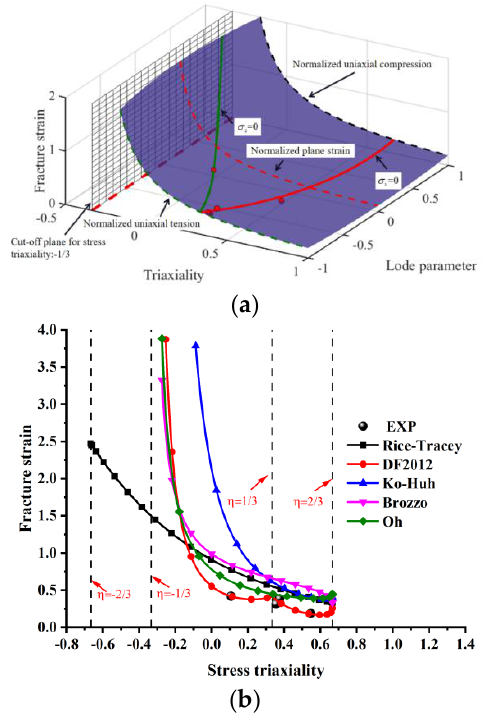
Figure 17. The fracture locus of QP980: ( a ) in the space of ( η , L , ε f ) predicted by DF2012; ( b ) in the space of ( η , ε f ) predicted by the traditional uncoupled ductile fracture criteria and DF2012.